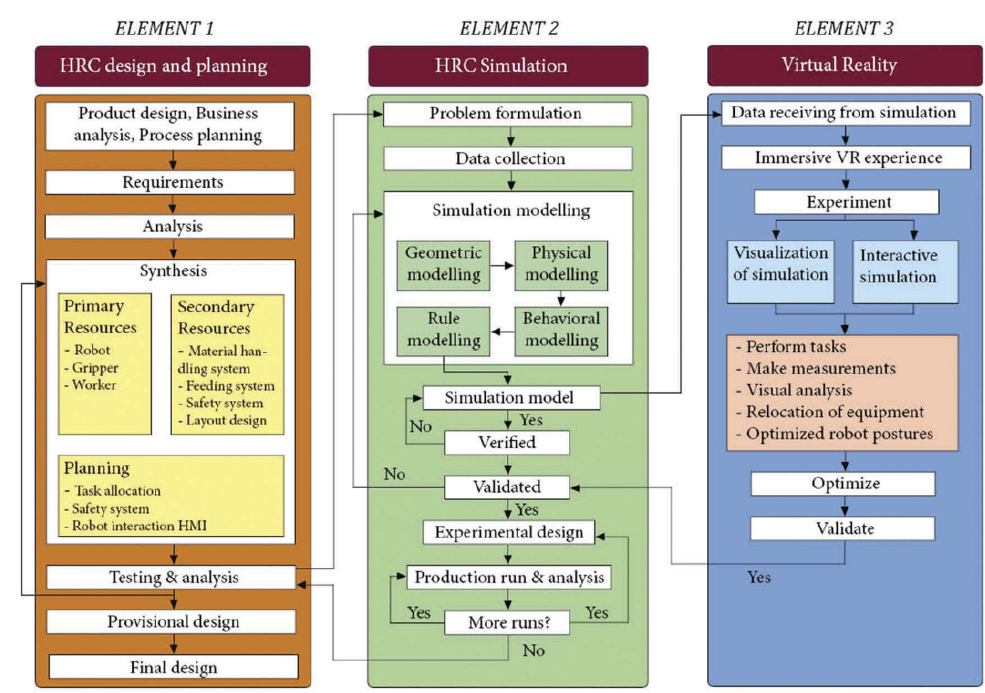
Figure 10. VR enhanced Digital Twin framework for HRC design [123].